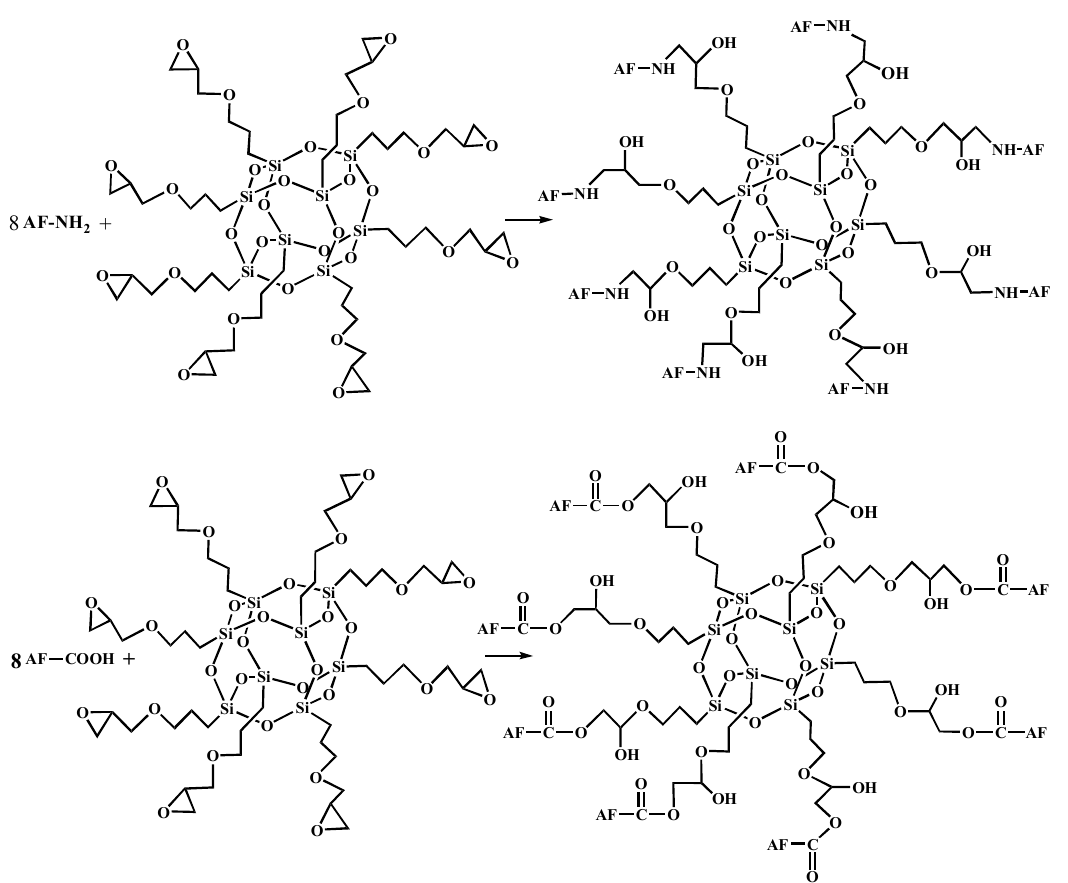
Figure 6. The terminal group reaction between aramid fiber and glycidyl-POSS.